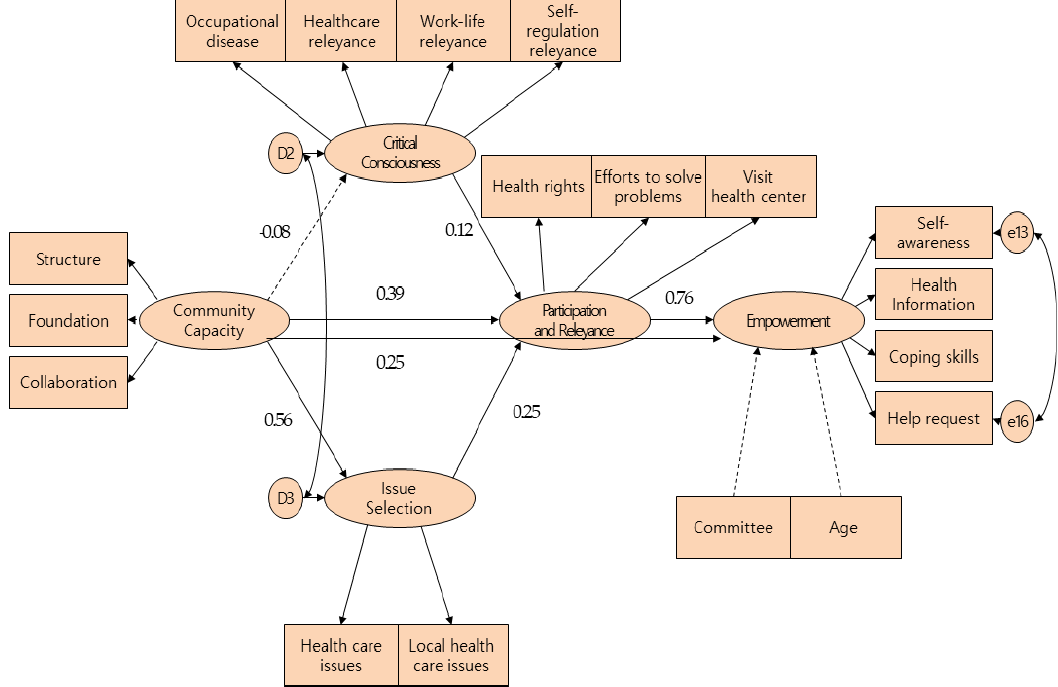
Figure 3. Path of modified model. χ 2 = 382.91 (df = 126), p ≤ 0.001 RMSEA = 0.07, NFI = 0.92, CFI = 0.95.